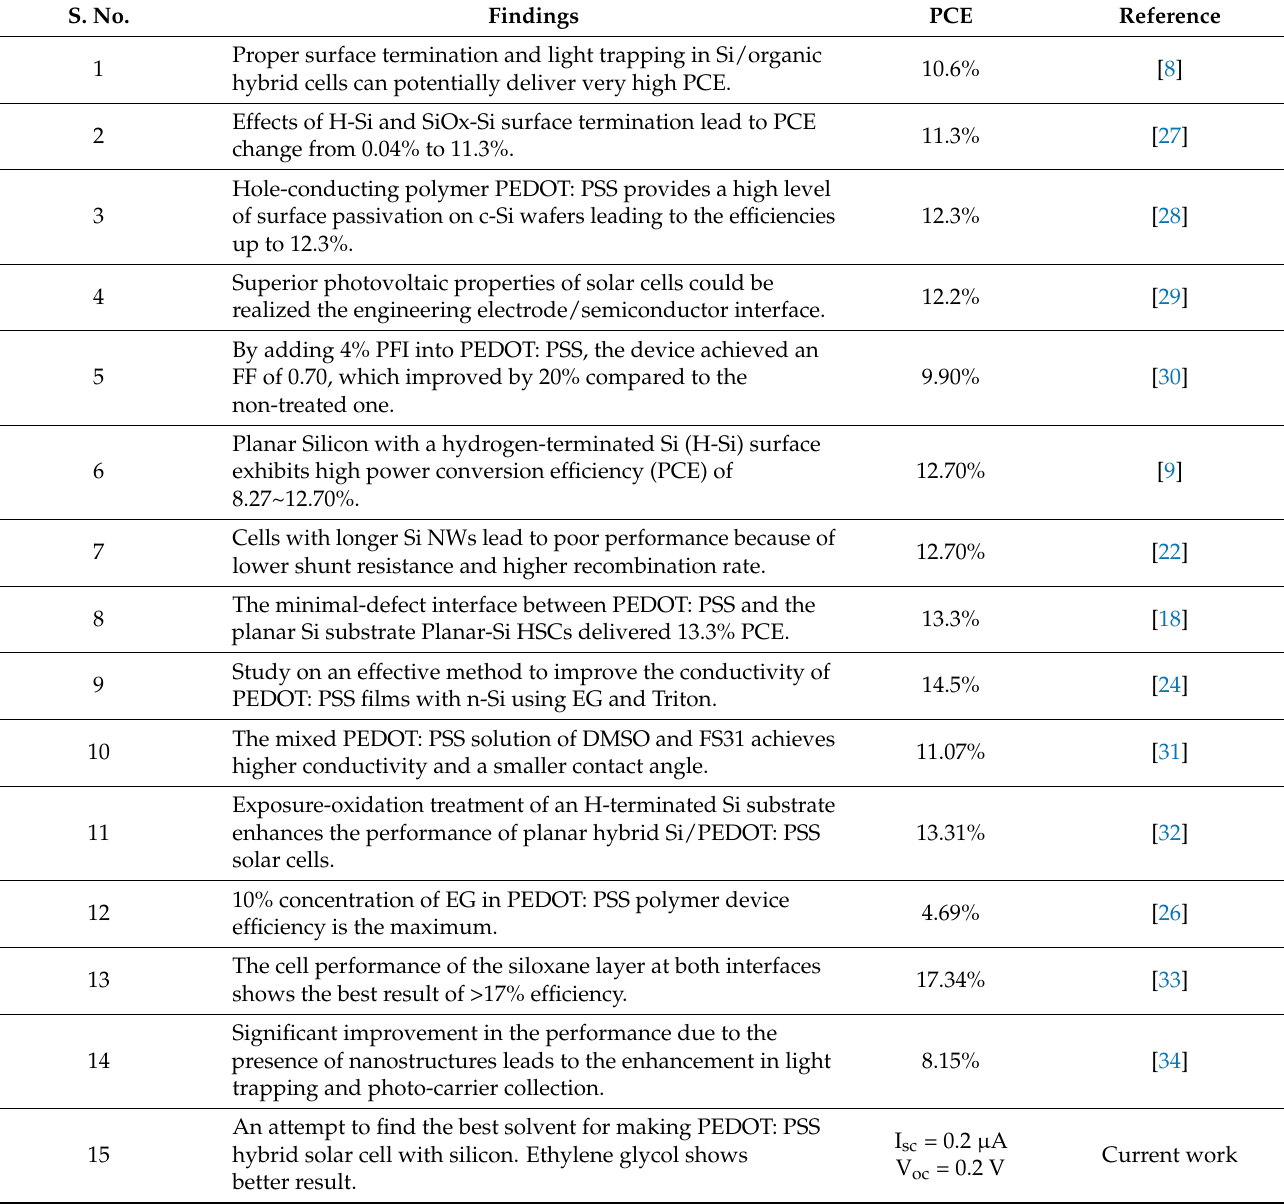
Table 3. Comparison of the performance of this work with others reported in the literature. S. No. Findings